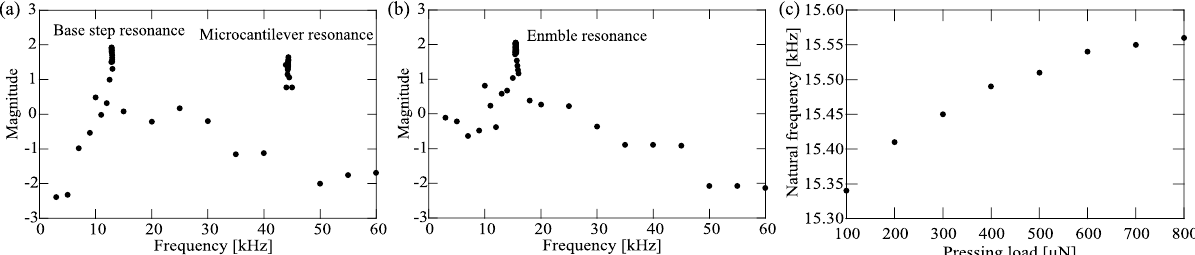
Figure 4. Frequency response curves with a log scale ( a ) in air and ( b ) under a 400 µ N pressing load. The first natural frequencies of the microcantilever and the base step in air were experimentally measured to be 44.35 kHz and 12.88 kHz, respectively. The first natural frequency under a 400 µ N pressing load was experimentally measured to be 15.49 kHz. Natural frequency of microcantilever under various pressing loads ( c ) with application of external excitation.